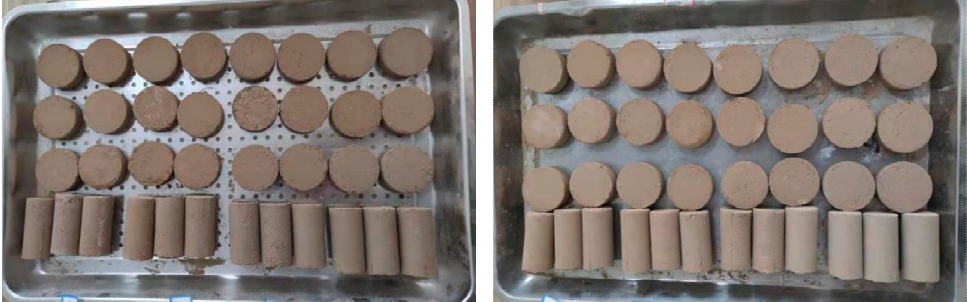
Figure 1. Finished samples of different